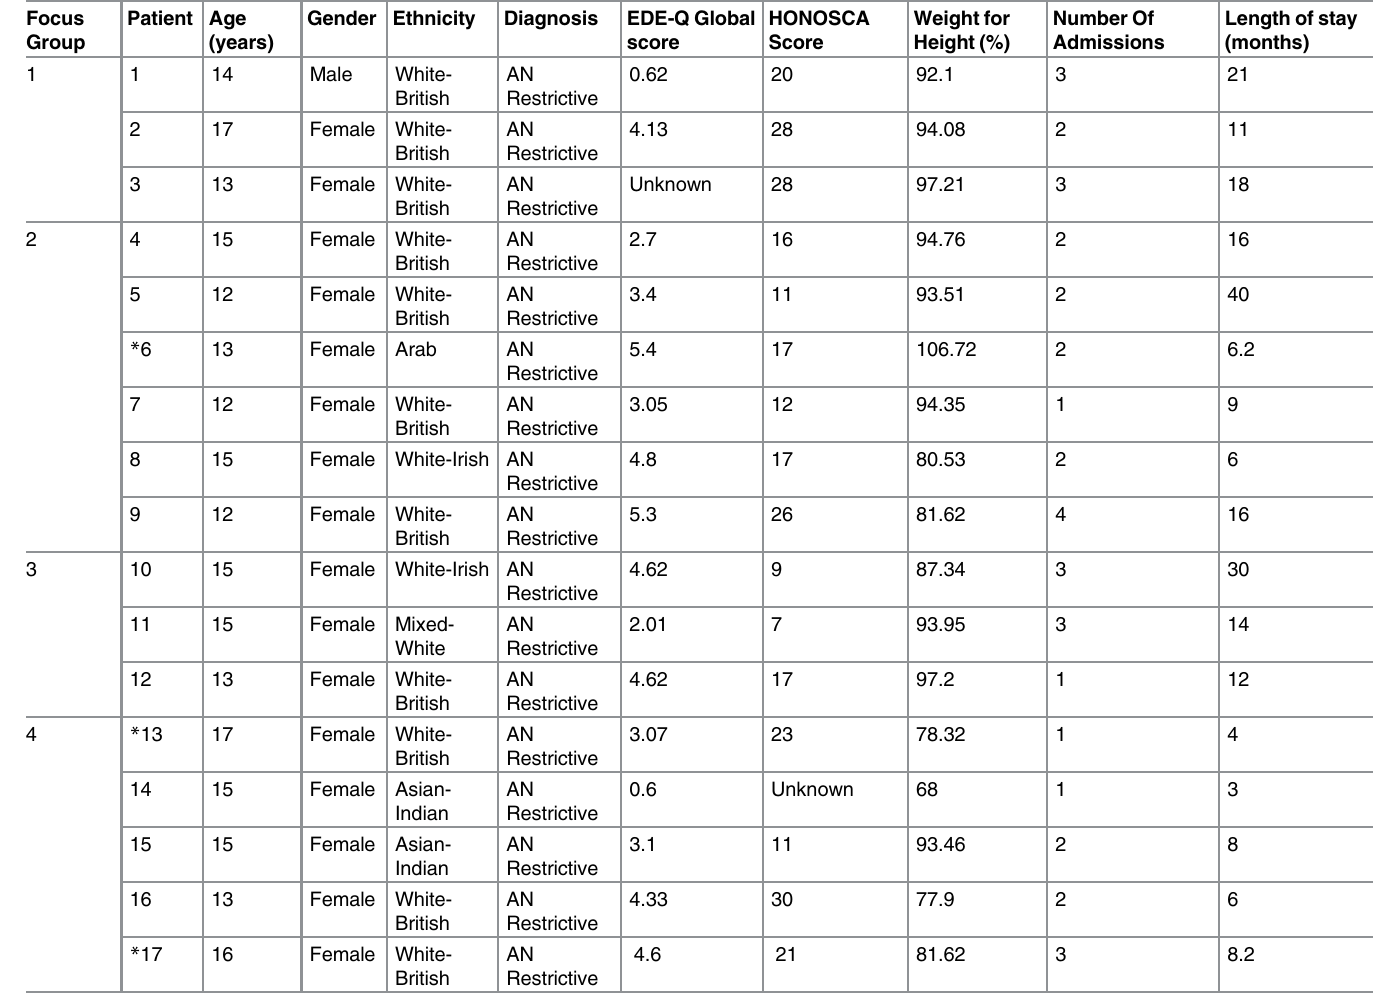
Table 1. Patient Demographics and